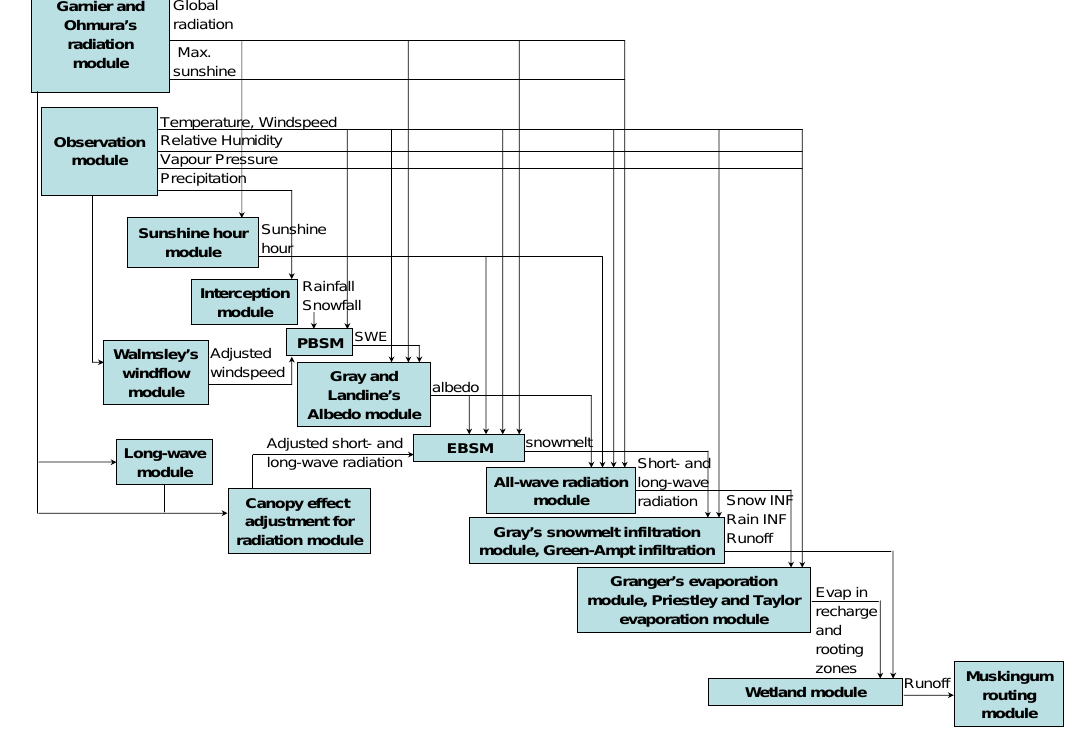
Fig. 2. Flowchart of physically based hydrological modules in